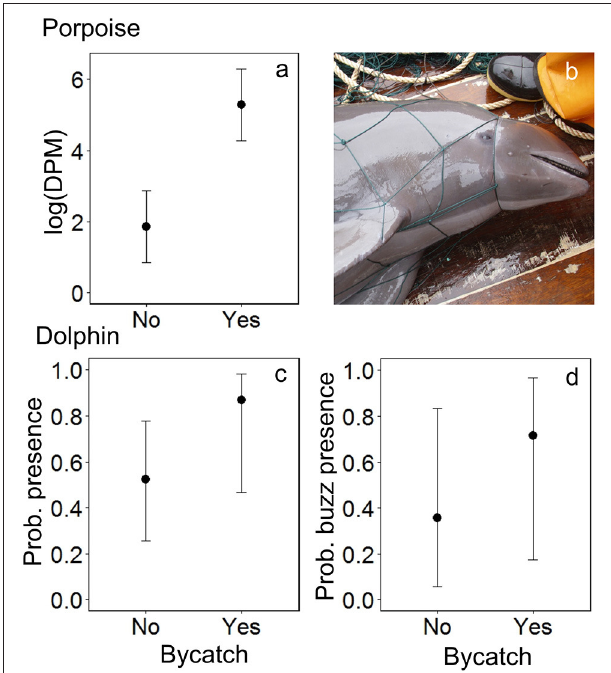
FIGURE 4 | The modeled relationship between bycatch of Burmeister’s porpoises Phocoena spinipinnis and dolphins (unspecified delphinids) and the acoustic activity recorded by C-PODs attached to fishing nets: for porpoises, (a) time spent (detection positive minutes, DPM), shown on the natural log scale, and for dolphins, (c) the probability of presence and (d) of buzzing activity. Error bars represent the 95% confidence intervals around modeled estimates. (b) A Burmeister’s porpoise Phocoena spinipinnis hauled onto the deck of an SSF vessel after becoming entangled in a driftnet in northern Peru. Photo credit: